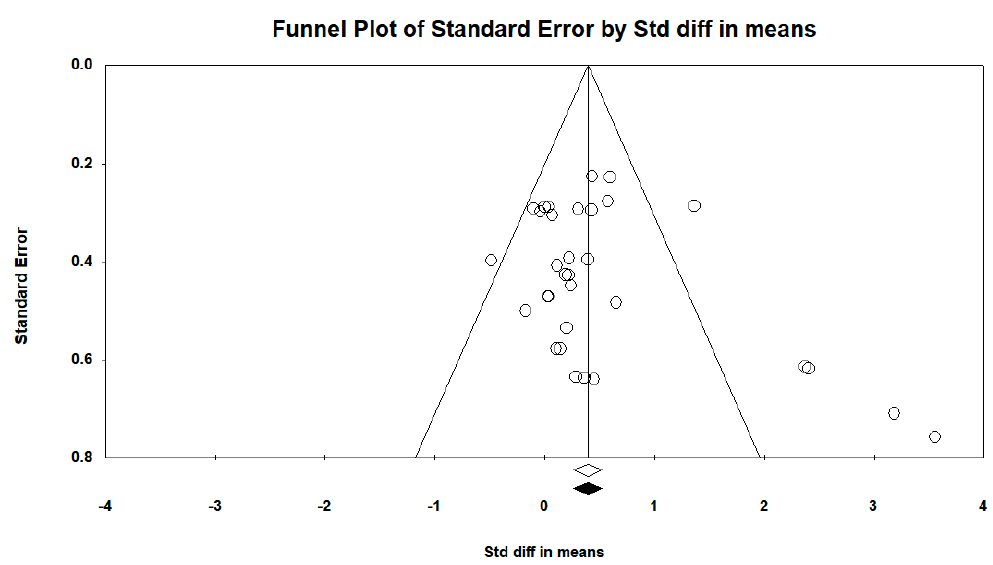
Figure 6. Funnel plot diagram of the standard error ( y -axis) and the SMD ( x -axis), after incorporating the Duval and Tweedie “trim and fill” procedure: pre–post intra-group difference in the intervention group with resistance therapy in all follow-ups.